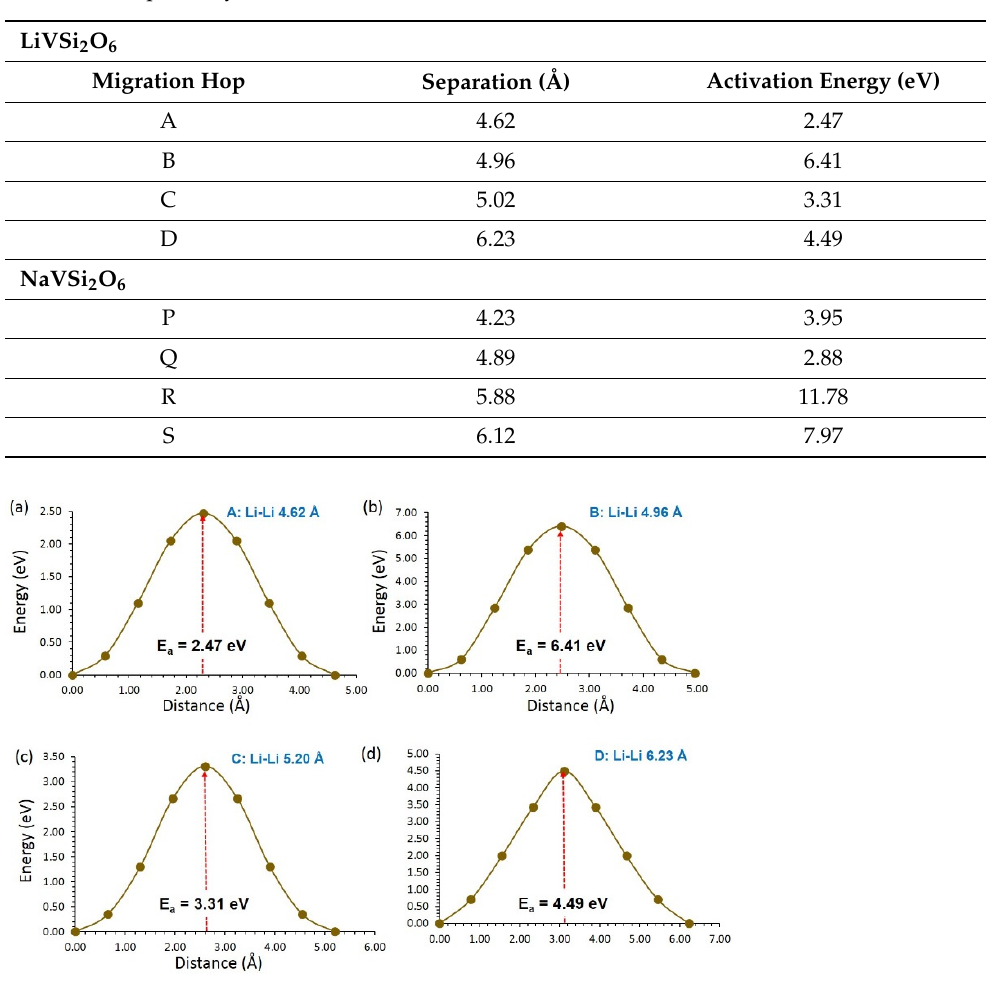
Figure 3. Migration pathways ( a ) Long-range Li-ion migration pathways (B → B → B → B, C → C → C → C and A → D → A → D) in LiVSi 2 O 6 and ( b ) long-range Na-ion migration pathways (P → P → P → P, R → R → R → R and Q → S → Q → S) in NaVSi 2 O 6 . Table 3. Activation energies for the migration of Li-ions and Na-ions in LiVSi 2 O 6 and NaVSi 2 O 6 , respectively.